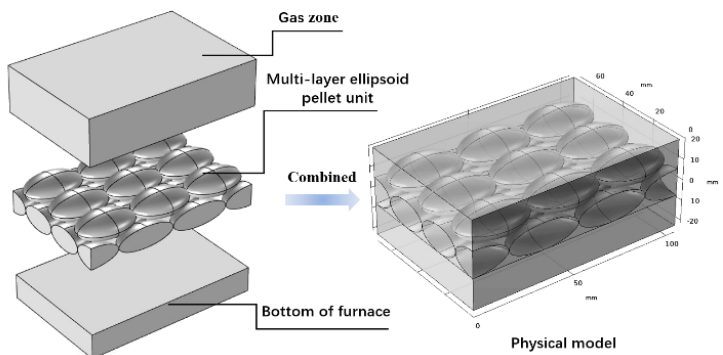
Figure 1 . Multilayer ellipsoid bed physical model. On the left is the specific structure diagram in separation, and on the right is the overall coupled bed physical model.